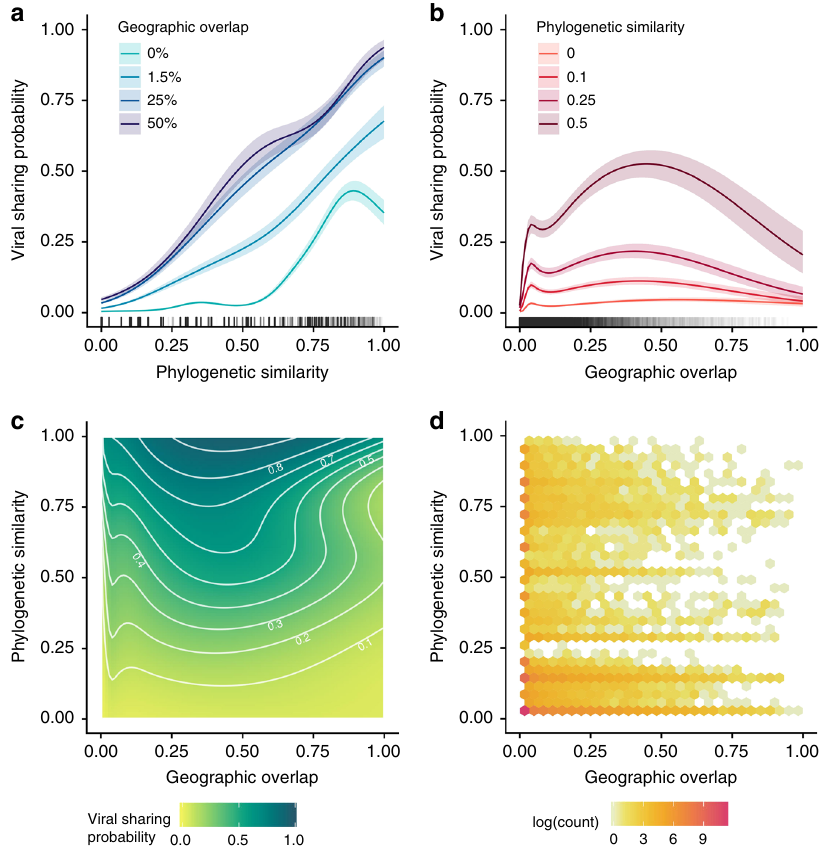
Fig. 1 Viral sharing GAMM outputs and data distribution. a Predicted viral sharing probability increases with increasing phylogenetic relatedness; the different coloured lines represent different geographic overlap values. b Predicted viral sharing probability increases with increasing geographic overlap; the different coloured lines represent different phylogenetic relatedness values. c The geographic overlap:phylogenetic similarity interaction surface, where the darker colours represent increased probability of viral sharing. White contour lines denote 10% increments of sharing probability. Labels have been removed from some contours to avoid overplotting. d Hexagonal bin chart displaying the data distribution, which was highly aggregated at low values of phylogenetic similarity and especially of geographic